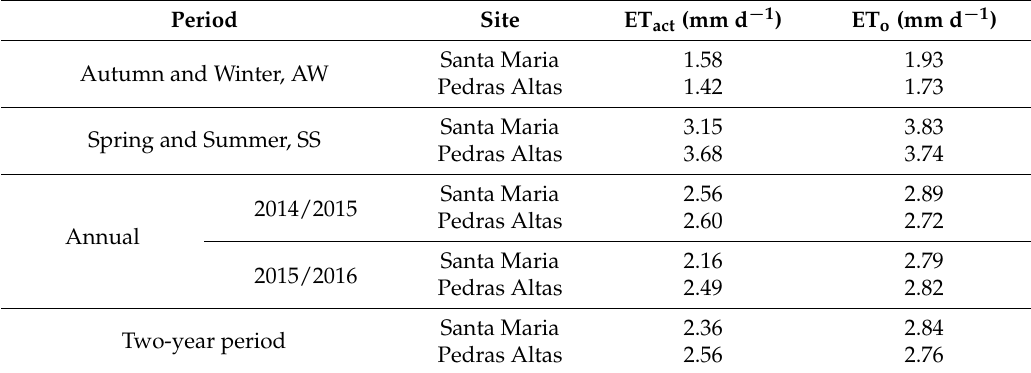
Figure 7. Seasonal variability of actual daily evapotranspiration (ET act ) at SMA and PAS sites from September 2014 to September 2016. The hatched areas refer to the AW periods. Table 3. Daily mean of actual evapotranspiration, ET act (mm d − 1 ), and reference evapotranspiration, ET o (mm d − 1 ), for the Pampa biome sites of Santa Maria and Pedras Altas relative to various periods.